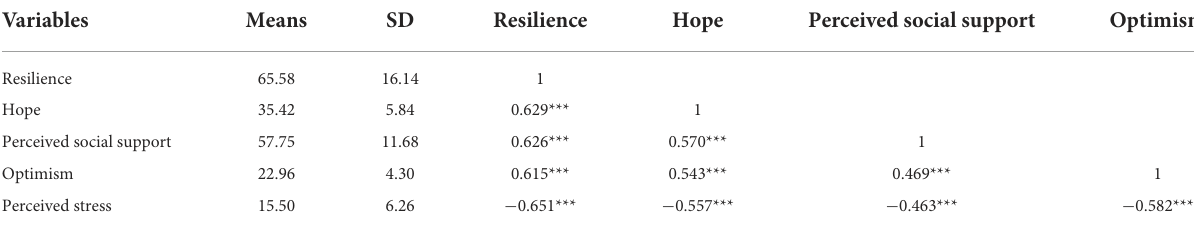
TABLE 2 Descriptive statistics and correlations among continuous variables ( n =